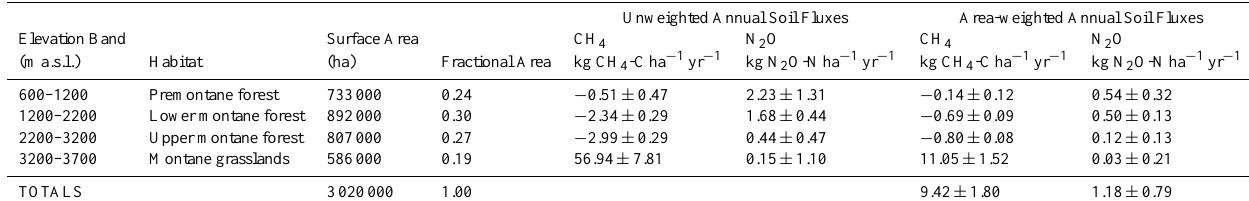
Table 5. Preliminary area-weighted flux estimates for the Kosñipata Valley, Manu National Park, Peru. Surface areas and fractional areas calculated from data published in Feeley and Silman (2010). Fluxes values reported here are means and standard